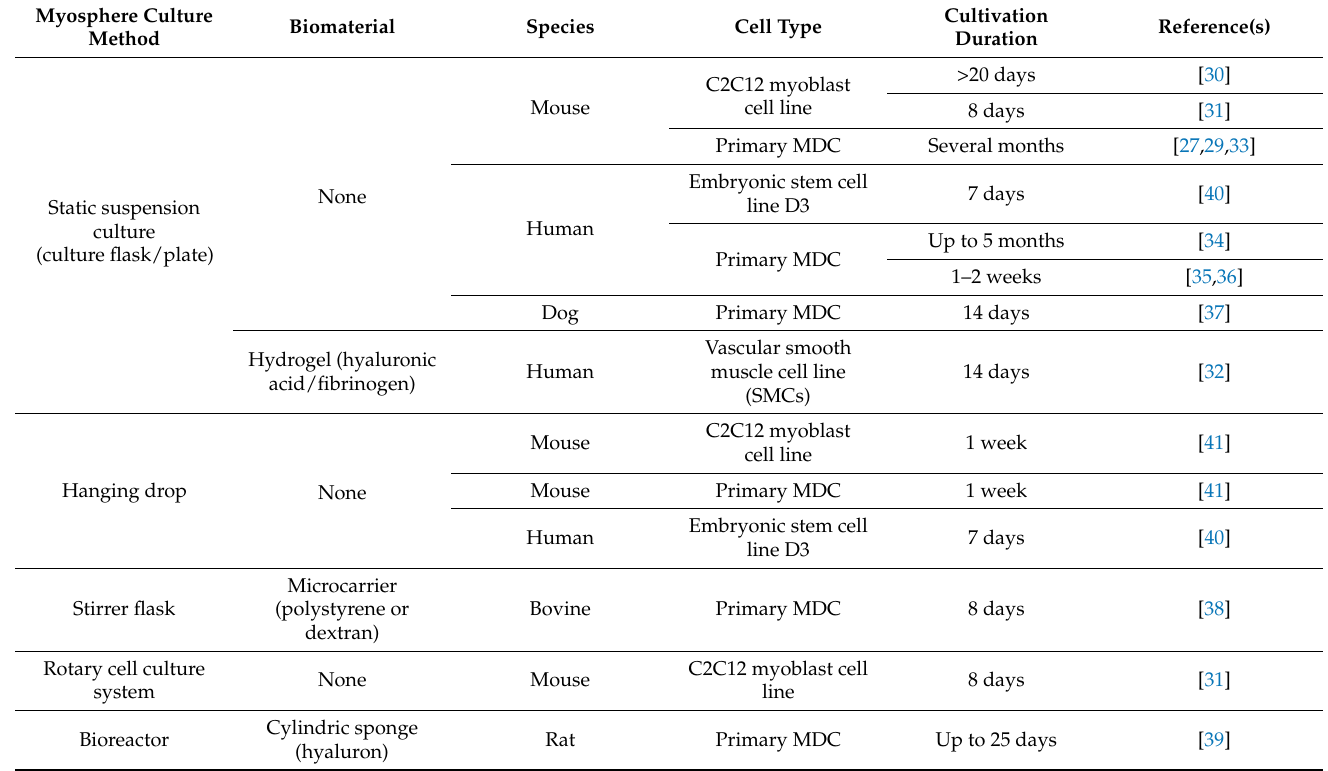
Table 1. Exemplary overview on studies involving myogenic spheroids generated with different